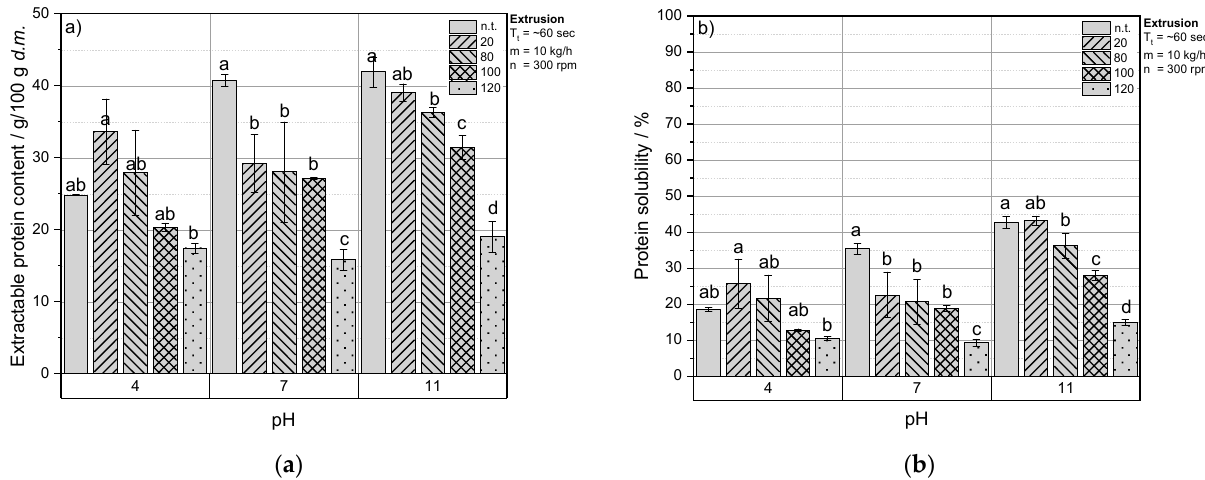
Figure 1. ( a ) Extractable protein content (g/100 g d.m.) and ( b ) protein solubility (%) at a pH of 4, 7 or 11 as a function of barrel temperature T B of extruded rapeseed press cake (RPC). Mean values with different superscript letters comparing the effect of barrel temperature T B within pH 4, 7 or 11 indicate significant differences ( p < 0.05) based on a two-way analysis of variance (ANOVA). Where appropriate, the mean values were compared using Tukey’s honest significance test. n.t. = not treated.